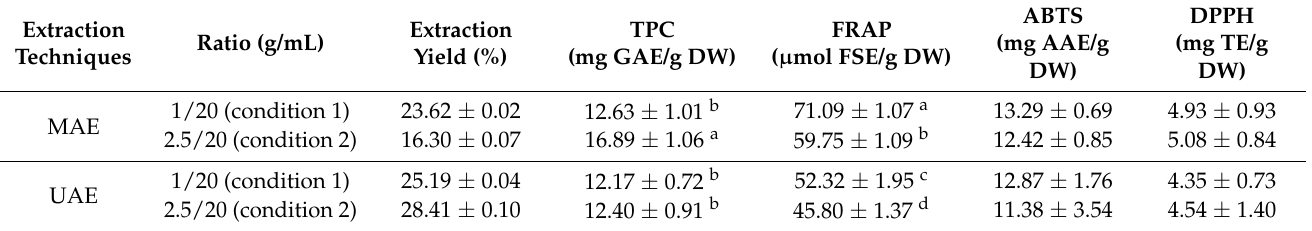
Table 1. Extraction yield, total phenolic content (TPC), in vitro antioxidant/antiradical activities (evaluated by ABTS, FRAP and DPPH assays) of C. pepo extracts prepared by MAE and UAE. Values are expressed as mean ± standard deviation ( n =